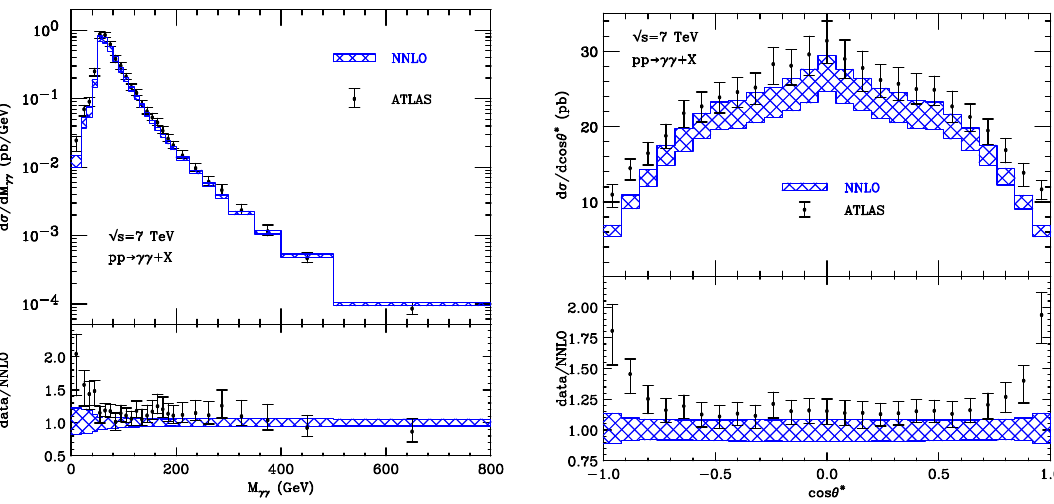
Figure 17 . Comparison between ATLAS data at √ s = 7 TeV [4] and NNLO results (including their scale dependence) for dσ/dM γγ (left) and dσ/d cos θ ∗ (right). The NNLO results are corrected for hadronization and underlying event effects (see